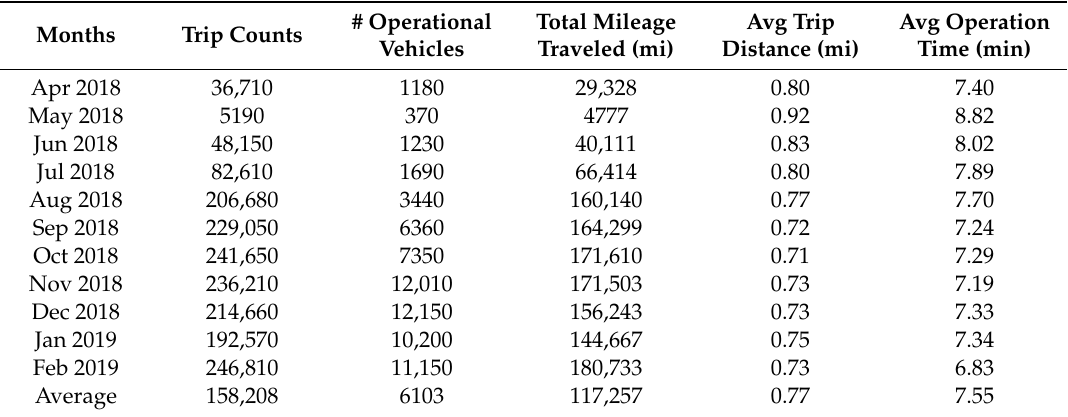
Table 1. Descriptive Statistics of E-scooter Trip Features by Month in Austin.